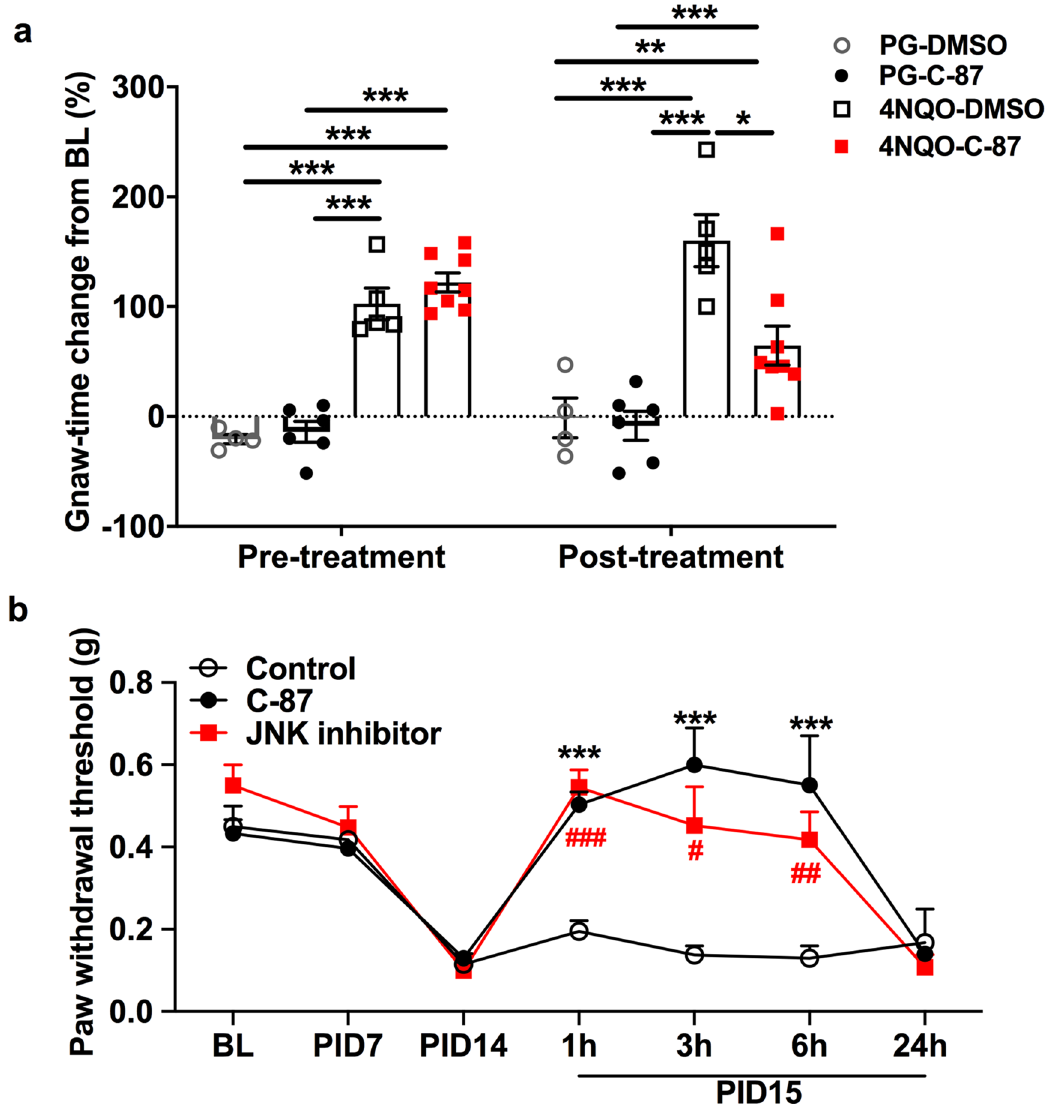
Figure 2. Blocking TNFα or JNK inhibits nociception in mice with cancer. ( a ) After 16 weeks of 4NQO treatment, mice exhibited significant increase in gnaw-time from its respective baseline (pre-injection). Propylene glycol (PG) treatment did not affect gnaw-time. In 4NQO tongue cancer mice, C-87 (12.5 mg/kg) IP injection significantly reduced percentage of gnaw-time change from baseline (n = 8) 1 h post-injection than the vehicle (10% DMSO) treated cancer mice (n = 5). C-87 (n = 6) or vehicle (n = 4) had no effect in non-cancer mice treated with PG alone. ( b ) Mice with paw SCC developed cancer pain at PID7. C-87 and the JNK inhibitor SP600125 treatment significantly reduced mechanical nociception compared to vehicle at 1, 3, and 6 h after treatment compared to the control group. 24 h after the treatment the analgesic effect of C-87 was gone (n = 5 per group, Two-way ANOVA). * P < 0.05; ** P < 0.01; *** P < tions of the following pro-inflammatory cytokines in the tumor paw compared to vehicle-treated tumor-bearing mice: TNFα (p < 0.05), NGF ( P < 0.05), IL1β ( P < 0.05), IL4 ( P < 0.05), IL28β ( P < 0.001), IL33 ( P < 0.01), MIP3α ( P < 0.01) (Fig. 3e). The other 35 cytokines measured from the MILLIPLEX MAP magnetic bead immunoassay were not significantly affected by the C-87 treatment (data not shown). TNFα antagonism disrupts oral cancer induced Schwann cell proliferation and mutual attrac- tion between Schwann cells and oral cancer cells. We have previously demonstrated that rat Schwann cells (RSC-96) and human oral SCC cells (HSC-3) reciprocally interact to promote proliferation, migration, and invasion 11 . Here we found that human Schwann cells increased migration and proliferation in the presence of human oral cancer cells as well; the growth rate of human Schwann cells was increased in the presence of either precancer dysplastic oral keratinocytes (DOK) or HSC-3 cells grown in culture inserts ( P < 0.001, Fig. 4a). Add- ing C-87 (20 μM) to the inserts containing HSC-3 cell culture reduced Schwann cell proliferation ( P < 0.001,